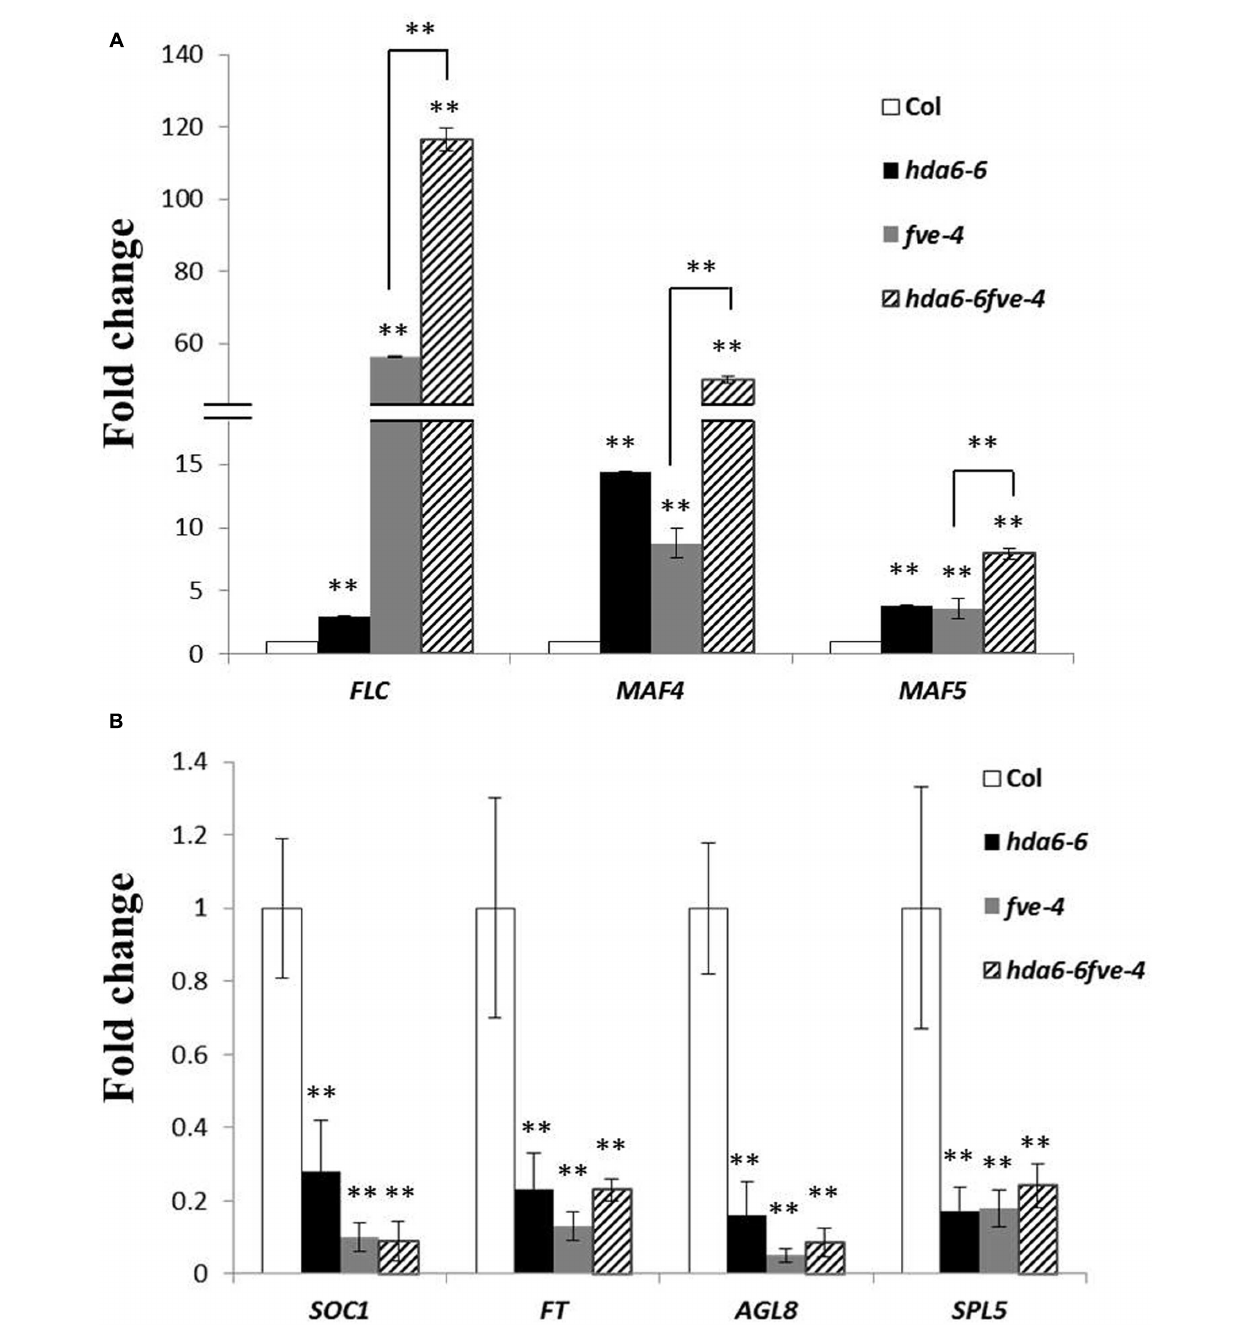
FIGURE 2 | Expression of flowering repressor and activator genes. (A) Real-time RT-PCR analysis of the expression of FLC , MAF4, and MAF5 in Col wild type, hda6-6 , fve-4, and hda6-6fve-4 plants grown under LD conditions for 20 days. The values shown are means ± SD. (B) Real-time RT-PCR analysis of the expression of SOC1 , FT , AGL8, and SPL5 in Col , hda6-6 , fve-4, and hda6-6fve-4 plants grown under LD conditions for 20 days. The values shown are means ± SD. ∗∗ Double asterisks denote statistical significance P < 0.01 ( t -test).